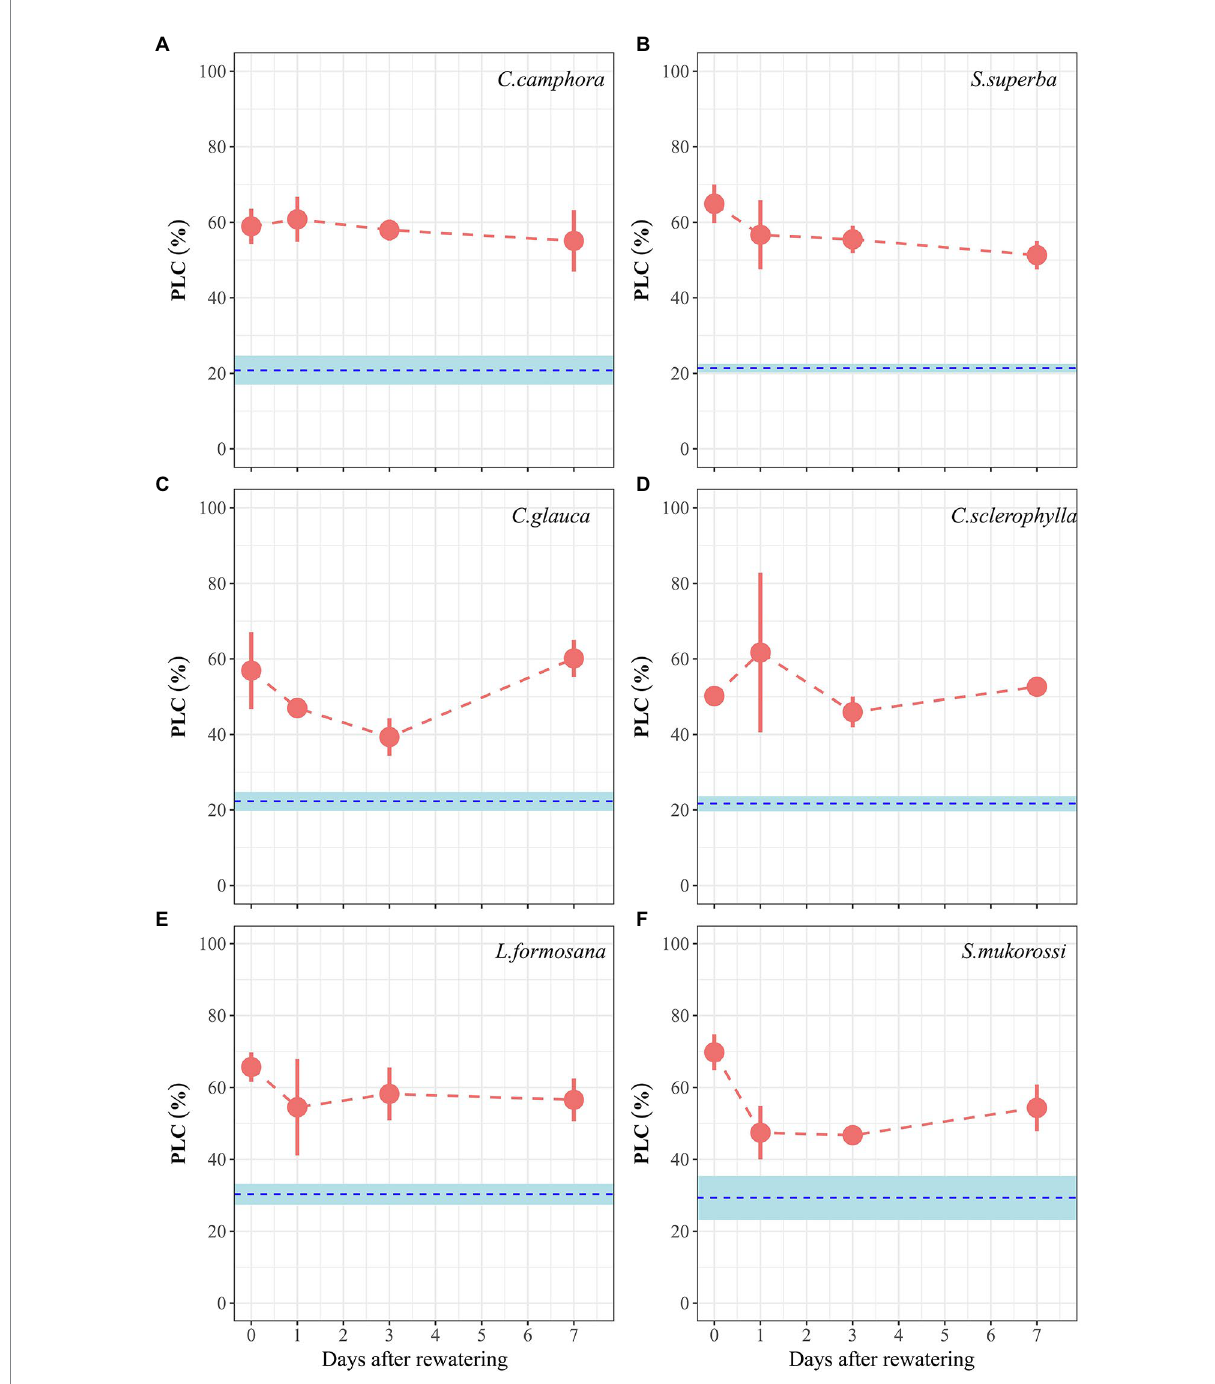
FIGURE 4 Time course of percentage loss of hydraulic conductivity (PLC) for seedlings of the six tree species during drought and recovery periods. Values are Means ± SE ( n = 3–4). Red symbols represent PLC values in the Drought treatment. The blue dashed lines and shade areas refer to PLC values (with SE; n = 4–10) for each species grown in the well-watered control treatment throughout the experimental period. Day 0 represents peak drought stress and thus the time for re-watering. The first four species are evergreen species, while the last two species are deciduous